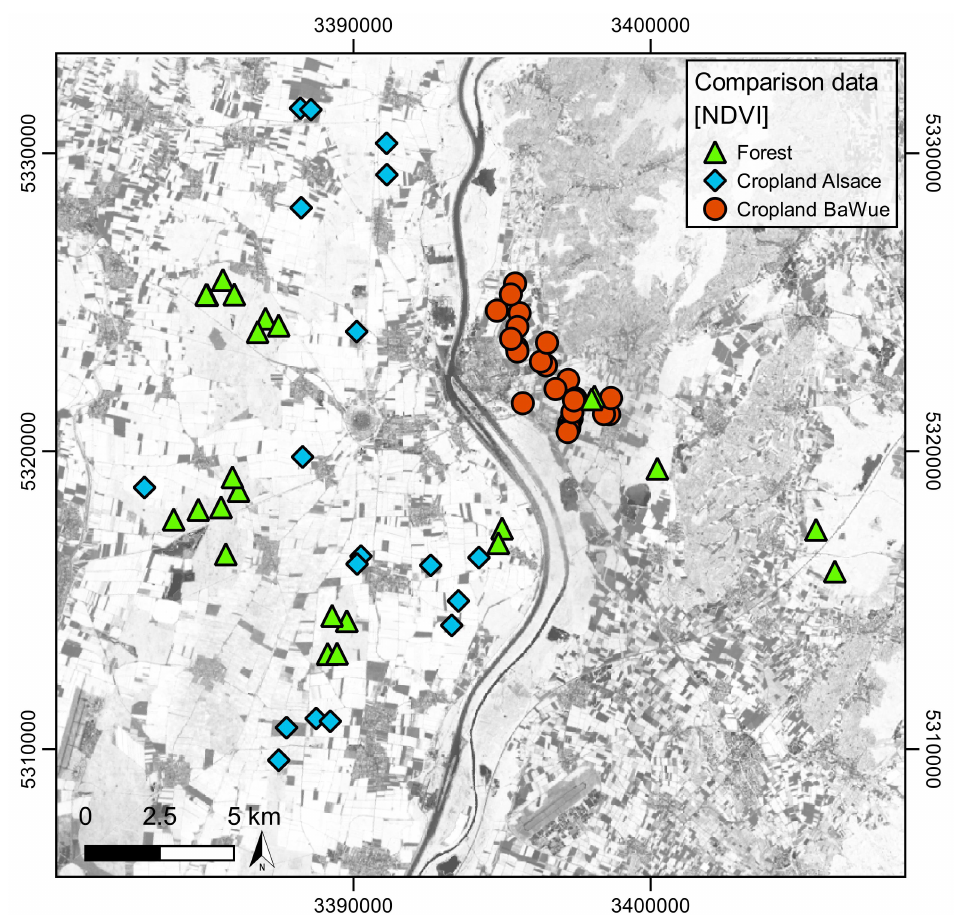
Figure 3. Location of the comparison dataset, which is composed of forest stands, Alsatian cropland, and cropland in BaWue.